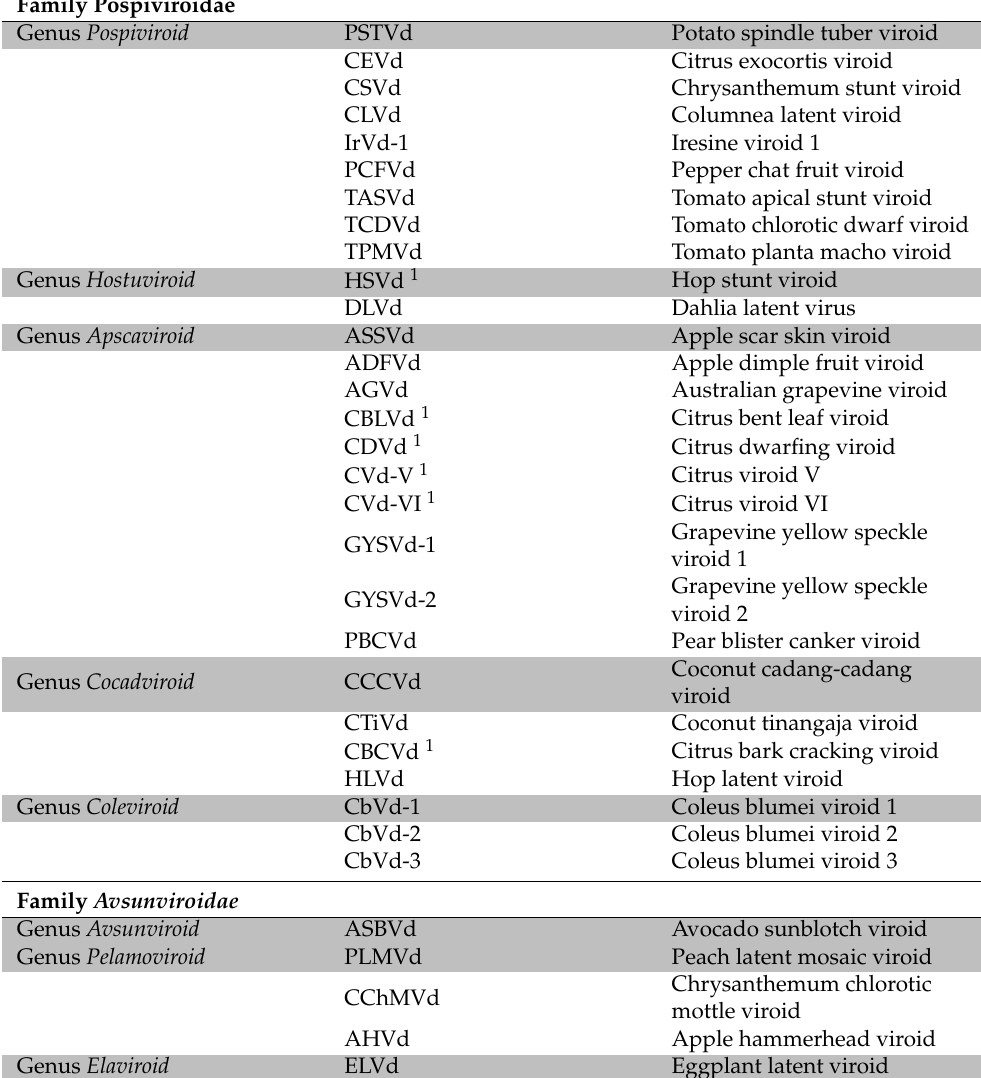
Table 1. ICTV taxonomic classification of viroids (2020). The 33 viroids are grouped into two families: Pospiviroidae , with five genera, and Avsunviroidae , with three genera. The type species of each genus is highlighted on a gray background. For each species, the abbreviation of its name is